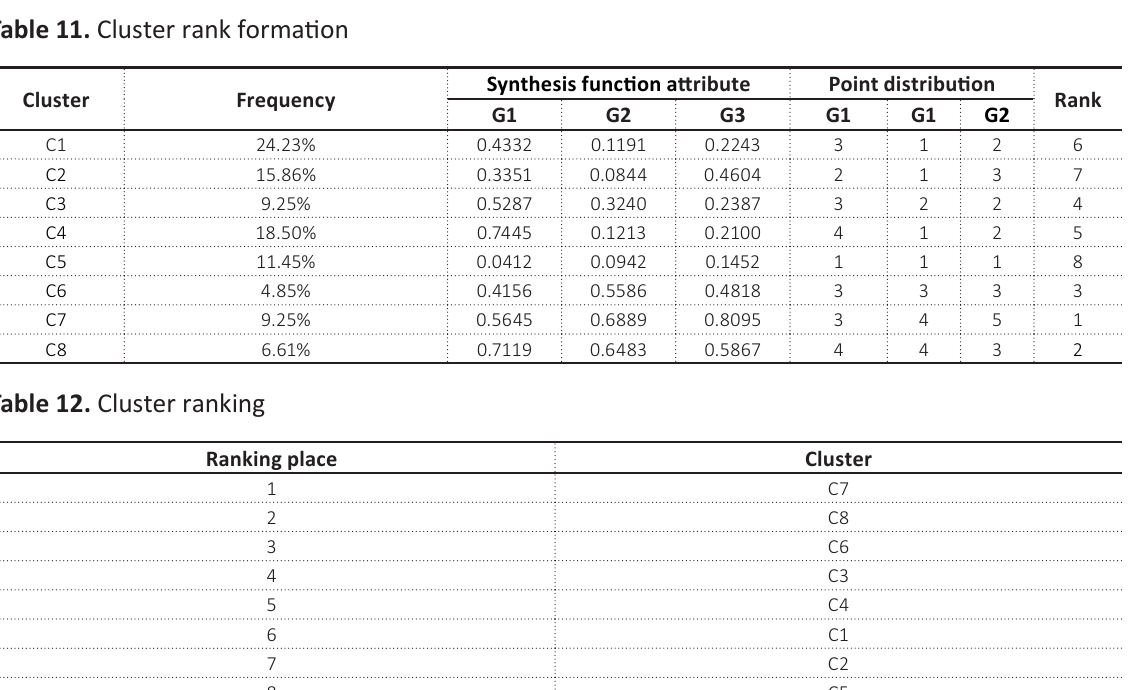
Figure 4. Obtained Kohonen maps by groups of indicators, considering conditional financial